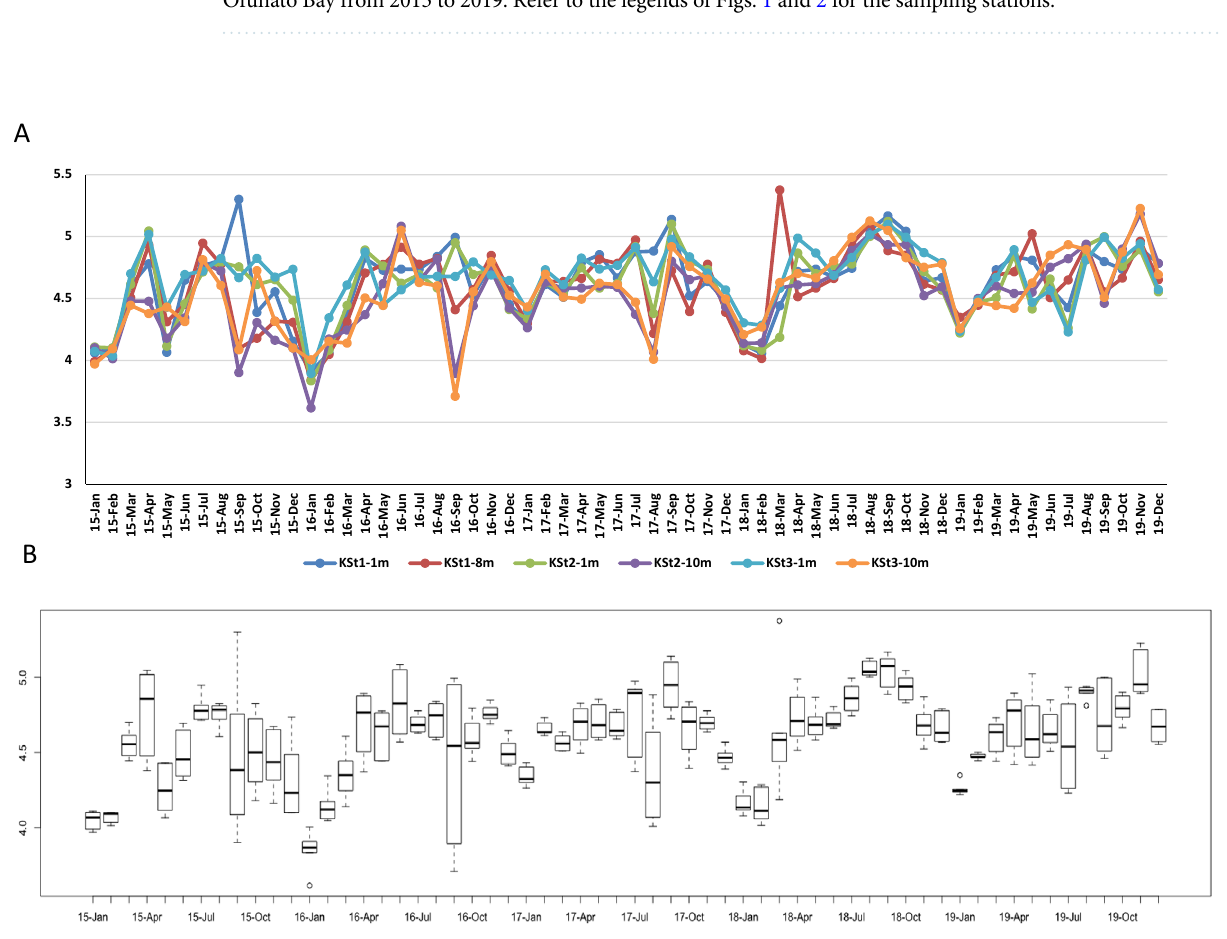
Figure 3. Clustering analysis of the bacterial community using datasets obtained from seawater samples collected from the 1 m depth (KSt. 1, KSt. 2 and KSt. 3) and 8 (KSt. 1) or 10 m (KSt. 2 and KSt. 3) depths in Ofunato Bay from 2015 to 2019. Refer to the legends of Figs. 1 and 2 for the sampling stations.